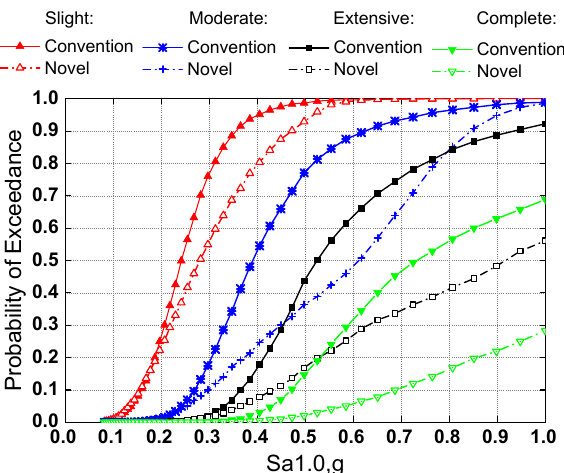
Figure 13. System fragility curve of conventional and novel bridges.